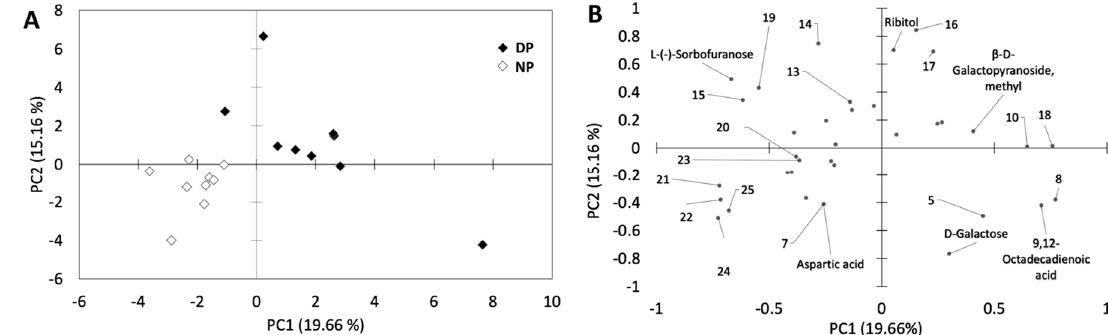
Figure 4. PCA score ( A ) and loading ( B ) plots of the metabolite profile from Musa AAA cv. Williams plants in the Acclimatization Phase II. N = normal plants D = dwarf plants. Metabolites numbers in the loading plot correspond to Table